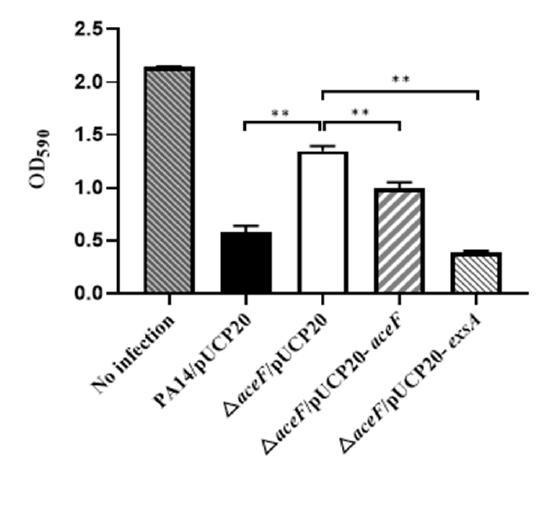
Figure 1. AceE, AceF and LpdG link glycolysis and the tricarboxylic acid (TCA) cycle.